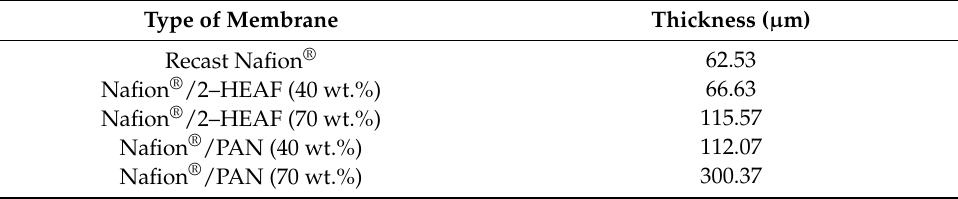
Table 1. Thickness of membrane from cross-sectional SEM analysis. Type of